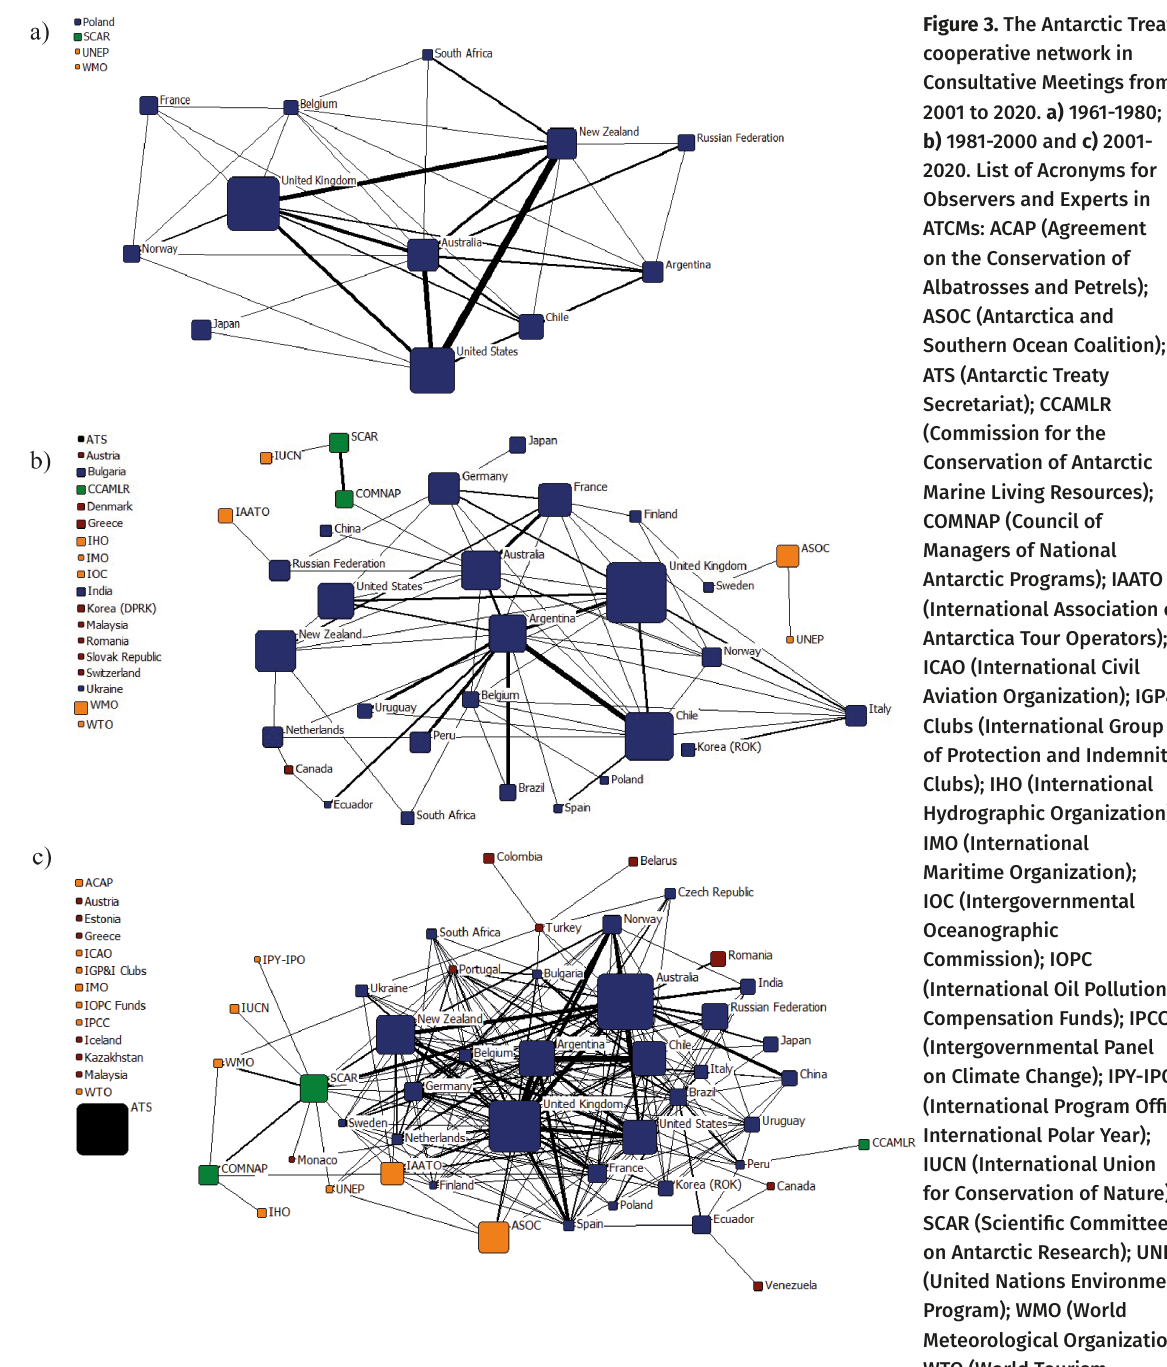
Figure 3. The Antarctic